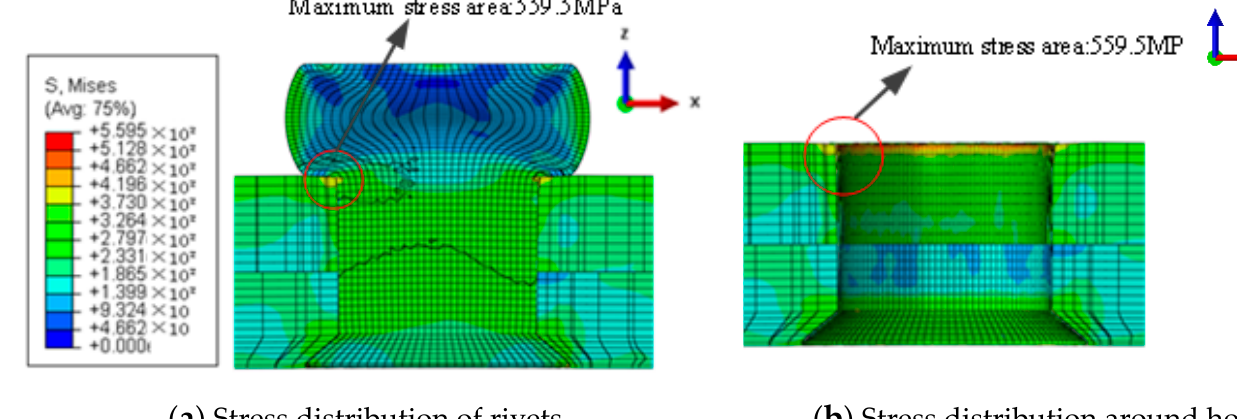
Figure 5. Mises stress distribution of riveted parts (unit: MPa) (local). After the riveting is completed, the residual circumferential stress on the joint is shown in Figure 6. It can be seen that the residual circumferential stress changes both in the radial direction and in the axial direction. The residual circumferential stress near the hole circumference presents a compressive stress state, which helps to prevent fatigue cracks from nucleating and prolongs the fatigue life of the joint. When away from the hole in the radial direction, the circumferential compressive stress gradually decreases and finally presents a state of tensile stress, and the stress in the tensile stress zone first increases and then decreases. The larger circumferential compressive stress is mainly distributed around the contact area between the driven head and the connecting hole. When the driven head and the rivet head are axially away, the compressive stress gradually decreases. The reason for this result is that the rivet rods at the driven head and nail heads are deformed severely and the amount of interference is large. From the overall observation, it can be seen that the compressive stress area on the driven head side is larger, while the compressive stress area on the rivet head side is smaller. This is due to the larger amount of interference on the driven head side and smaller interference on the rivet head side. Since the compressive stress area of the rivet head side is small, it is easier to become the origin of fatigue cracks than the driven head side.